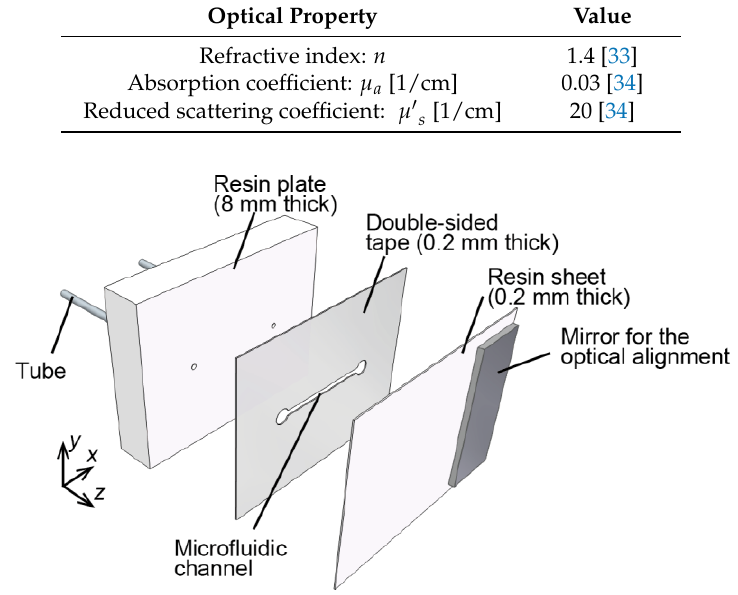
Figure 2. Components of the microfluidic phantom. A 0.2-mm-depth flow channel is positioned at 0.2 mm deep. Flow channel was formed by cutting a piece of double-sided tape, and 0.2-mm-thick resin sheet was adhered to the resin plate with the double-sided adhesive tape.